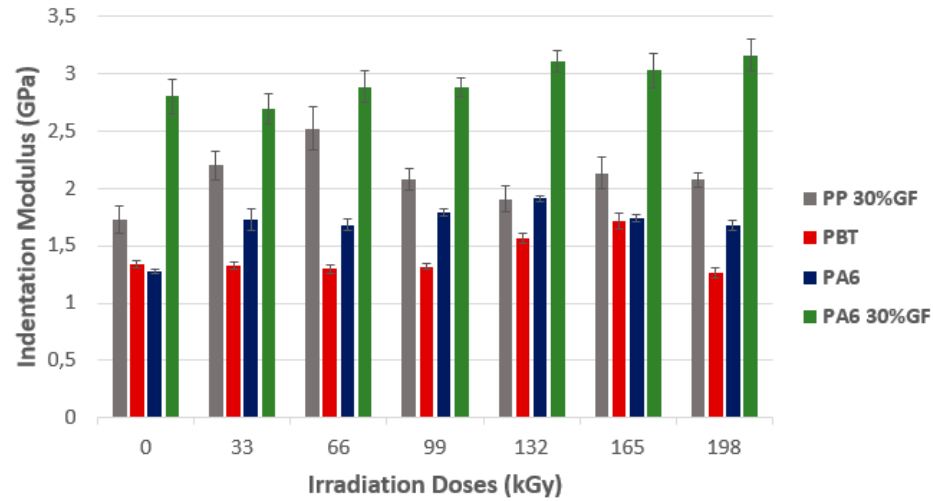
Figure 12. Indentation modulus ( E IT )—Technical polymers.